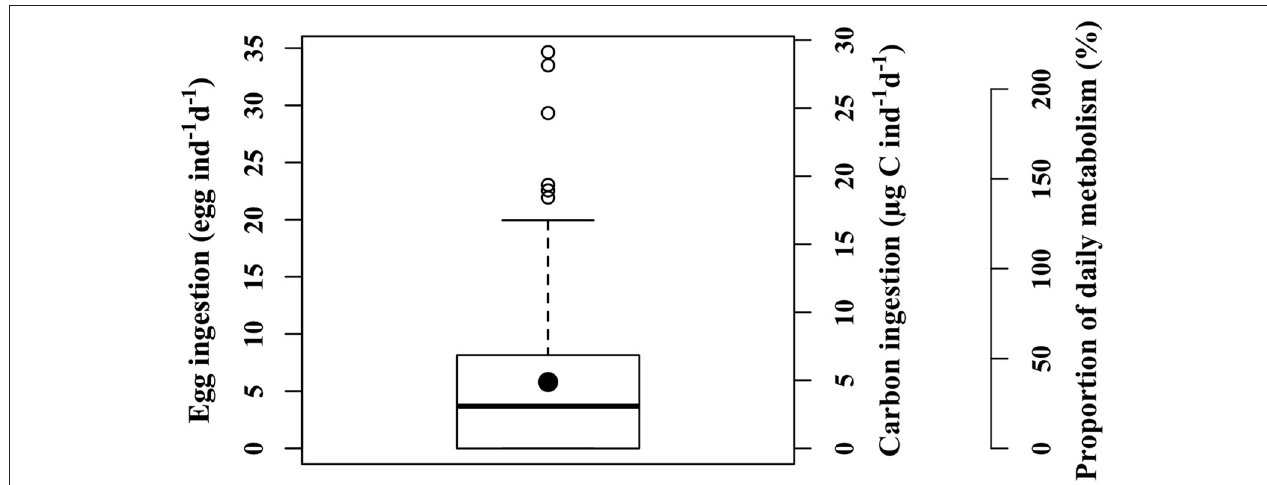
FIGURE 2 | Ingestion rates of female M. longa on C. hyperboreus eggs from all experiments according to different units: number of eggs, carbon content, and proportion of daily metabolic needs (see text). Thick black line: median; black circle: mean; box: range between the first and third quartiles (IQR); whiskers: ± 1.5 IQR; open circles: outliers.